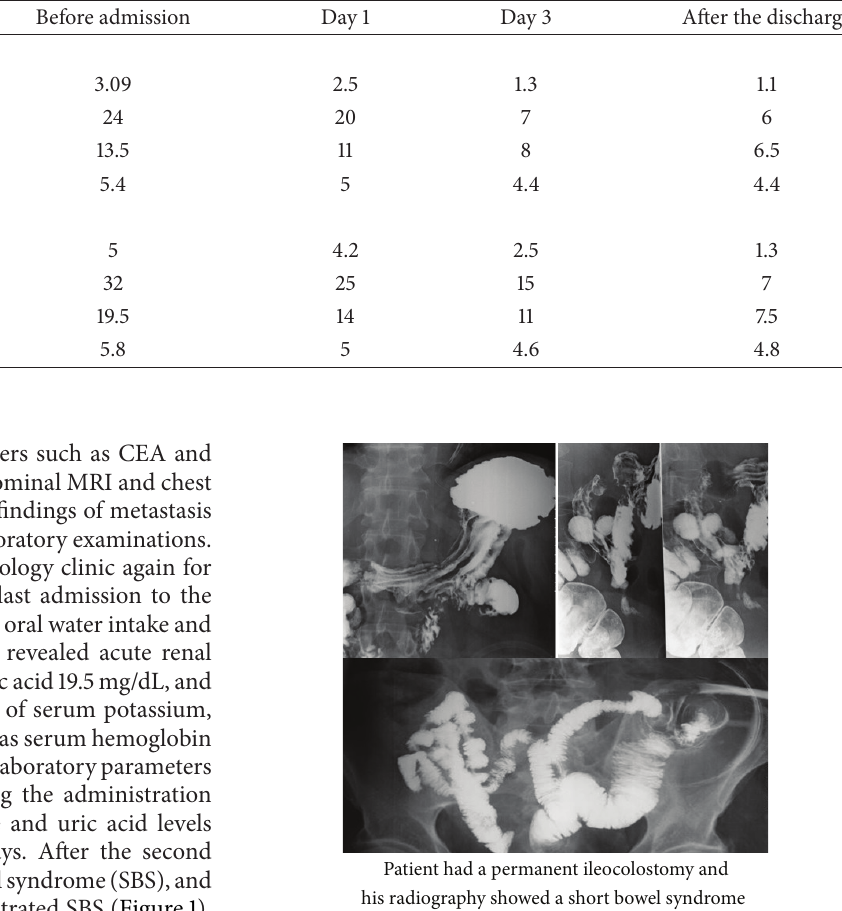
Figure 1: Radiological examinations demonstrated the short bowel